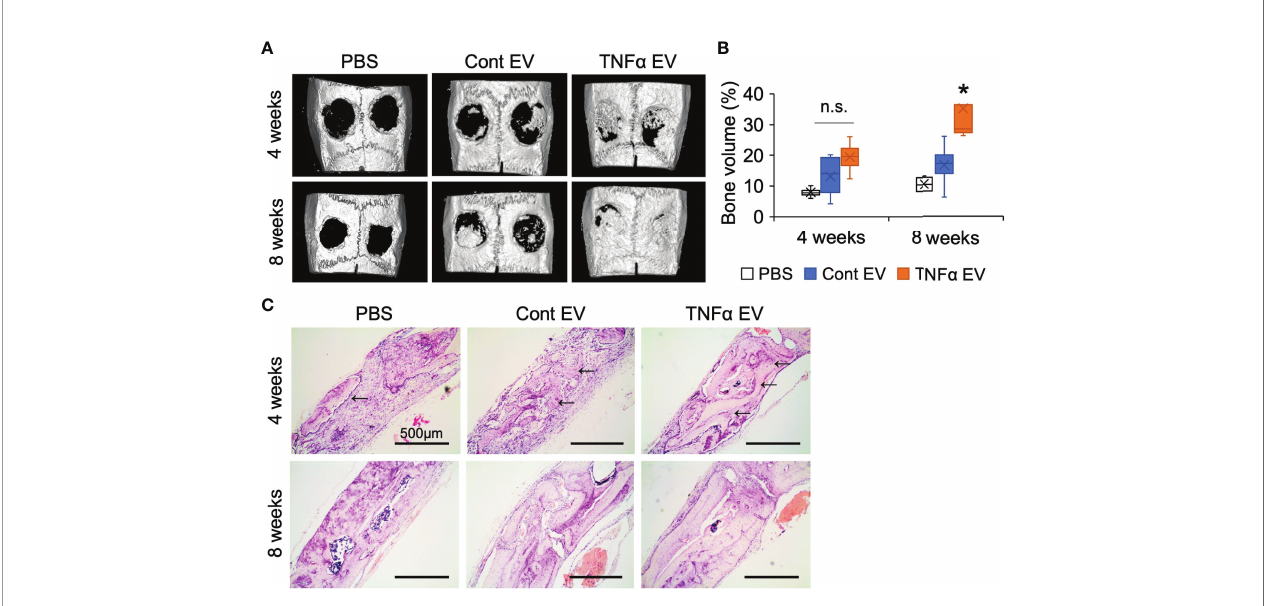
FIGURE 6 | Bone regeneration is in fl uenced by TNF a EVs. (A) Representative 3D m CT images of rat calvarial defects 4- and 8-weeks post wounding. Note the increased presence of bone in EV groups compared to control and the increased bone volume in the TNF a EV group compared to the other two. (B) volumetric quantitation of regenerated bone represented as percentage of BV/TV. Note the signi fi cant increase in bone volume at 8 weeks in the TNF a EV group compared to controls. n.s, Not signi fi cant;*: statistical signi fi cance (P < 0.05) with respect to PBS and control EV group as calculated by Tukey ’ s test post ANOVA. (C) Representative micrographs of calvarial defect sections stained with H&E. Black arrows point to newly formed bone in the defect. Scale bar=500 m